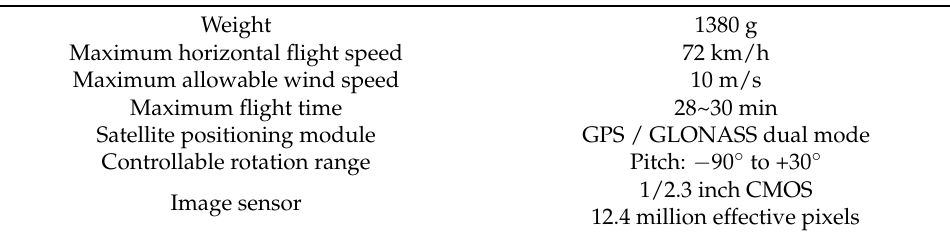
Table 4. DJI Phantom 4A